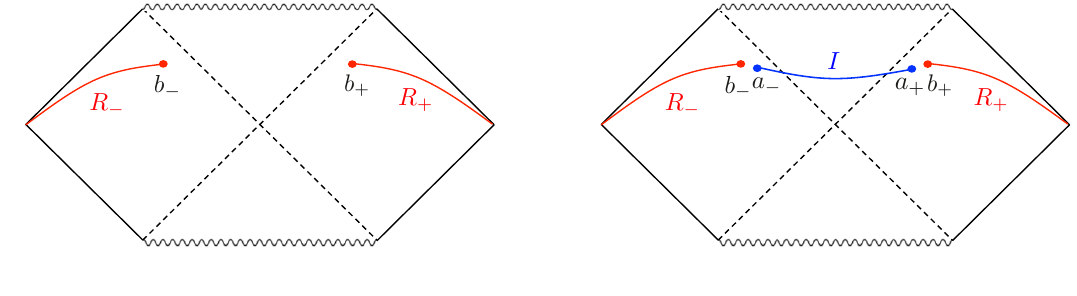
Figure 1 . Penrose diagram of the static Schwarzschild spacetime without island (left) and that with an island I (right). The region R whose states are identi(cid:12)ed with the Hawking radiation has two parts R + and R , which are located in the right and the left wedge, respectively. The boundary (cid:0) surfaces of R + and R are indicated as b + and b , respectively. The island extends between the (cid:0) (cid:0) right wedge and the left wedge. The boundaries of I are located at a + and a . At late times, the (cid:0) distance between the right wedge and the left wedge is very